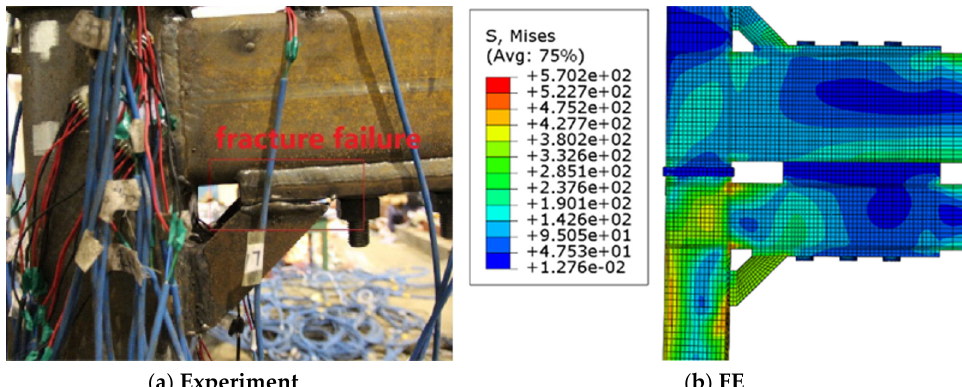
Figure 3. Test [28] and FE lateral load-deflection curves.